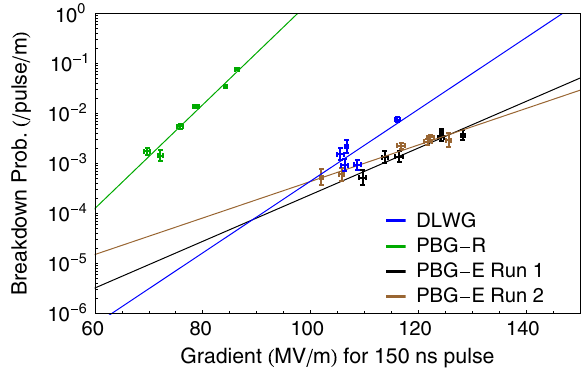
FIG. 17. Breakdown probability per pulse per meter of struc- ture vs gradient at 150 ns pulse length for the PBG-R, PBG-E, and a conventional disk-loaded waveguide structure with the same iris geometry (DLWG). The two data sets for the PBG-E represent the beginning and end of testing.